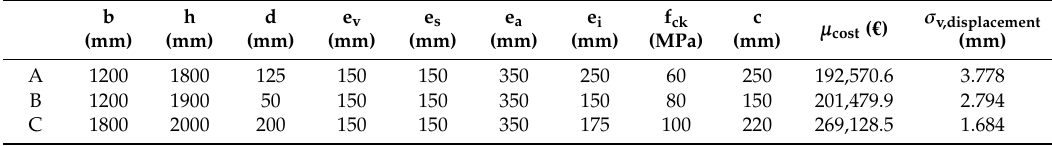
Table 5. Comparison of different designs of the Pareto Frontier with a 20% variation of the modulus of elasticity.